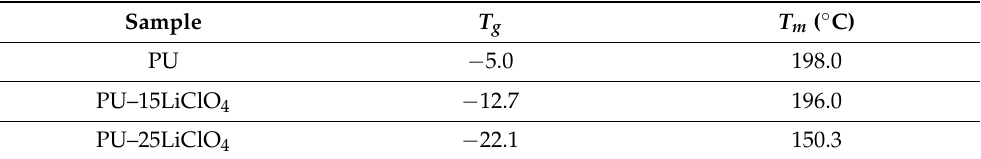
Table 5. T g and T m of PU, PU–15LiClO 4 , and PU–25LiClO 4 .